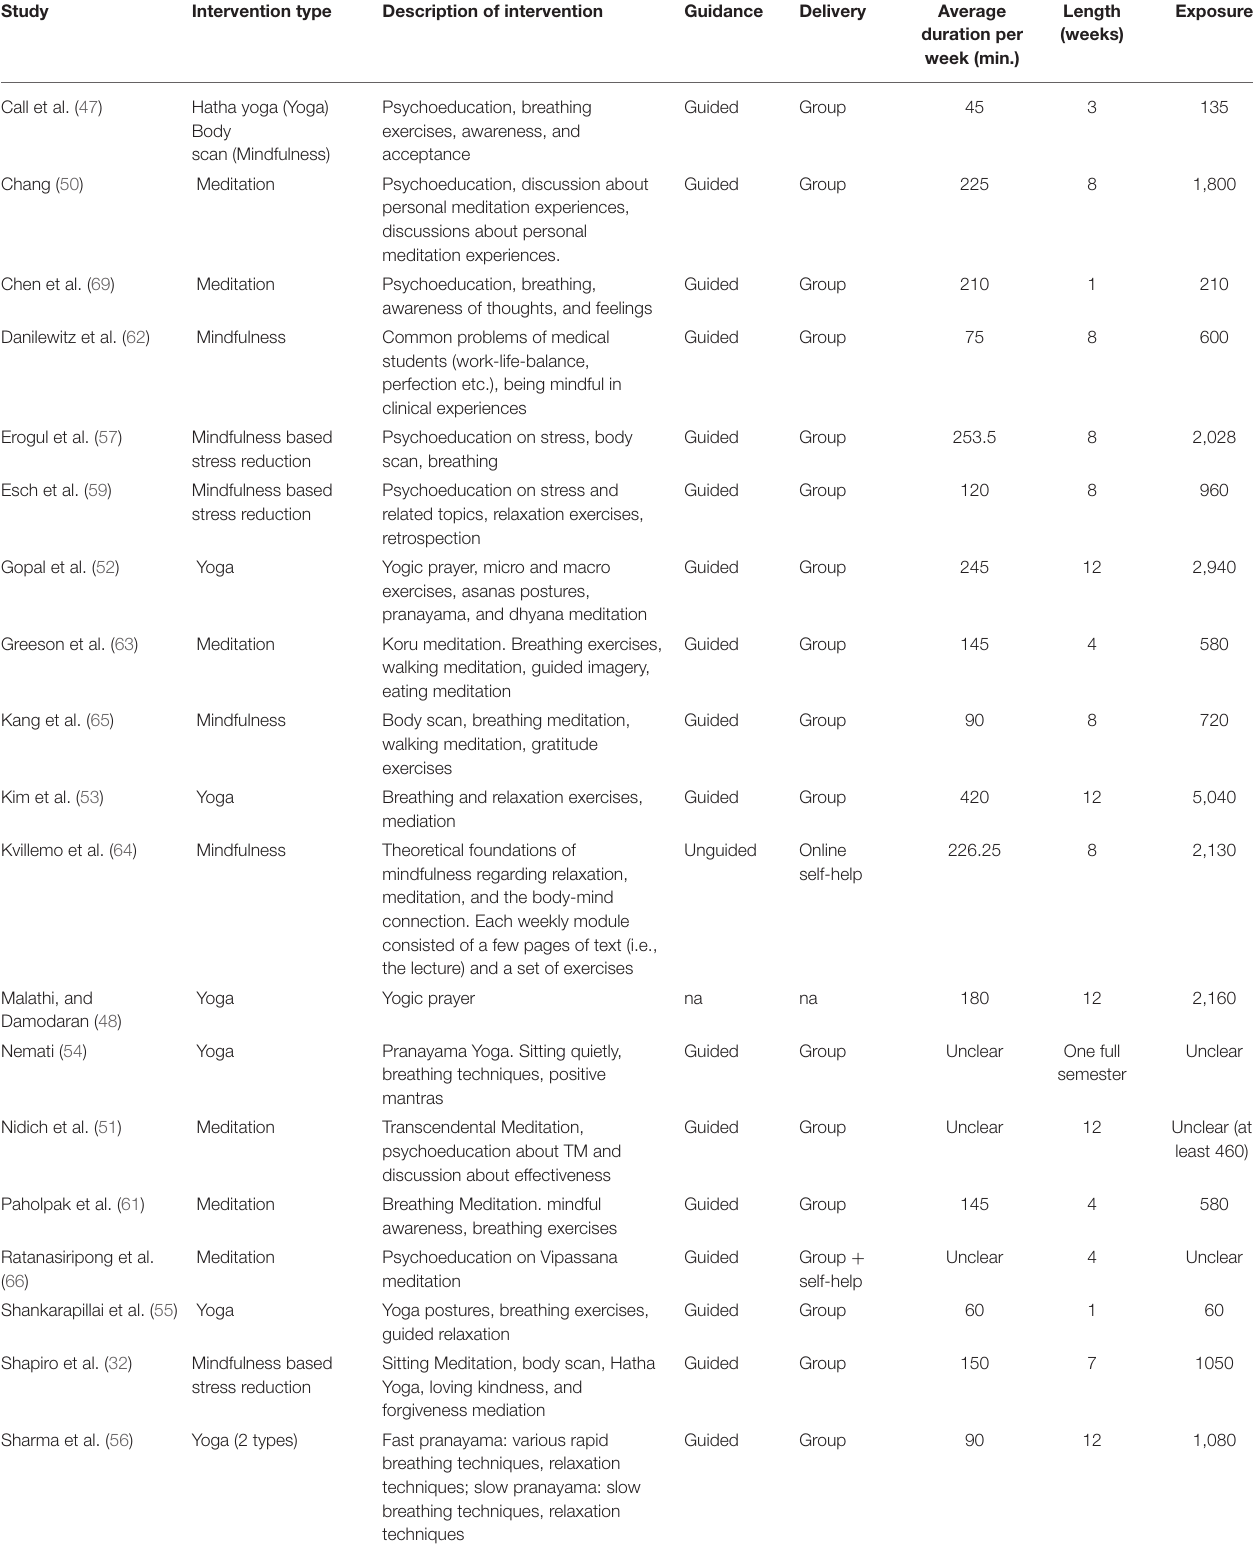
TABLE 3 | Intervention